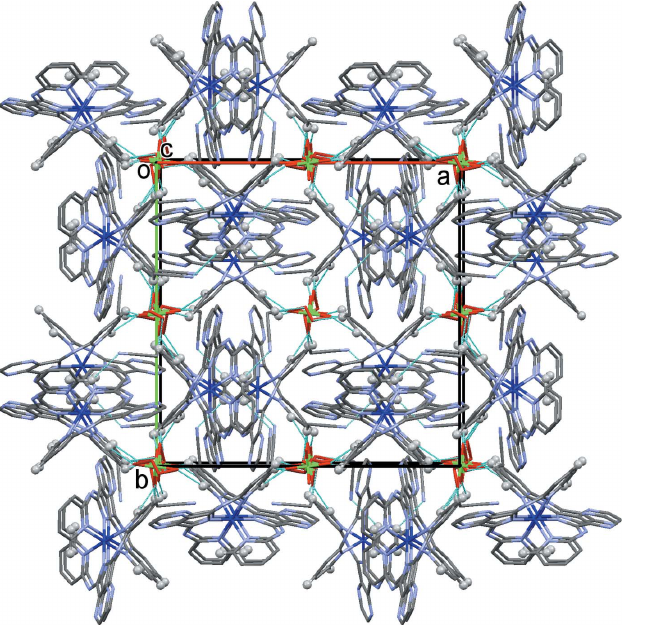
Figure 2 A view along the c axis of the crystal packing of the title compound. The hydrogen bonds are shown as dashed lines [see Table 1; only the H atoms (grey balls) involved in hydrogen bonding have been included].